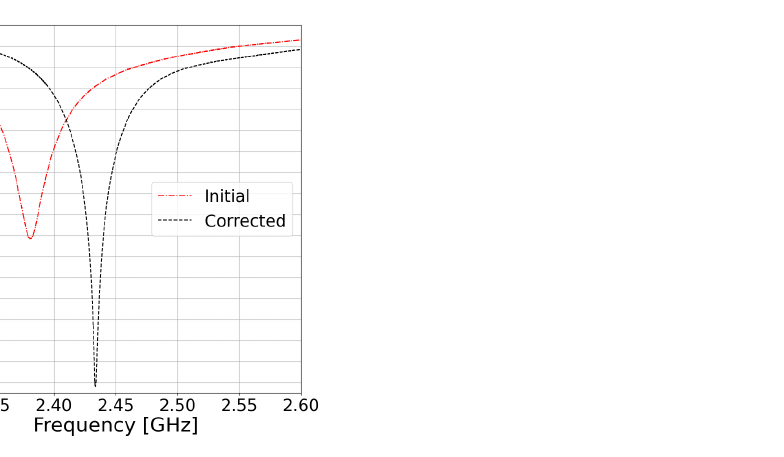
Figure 3. The measured resonance of the U.FL − based IRMA with the resonant frequency- compensated design.